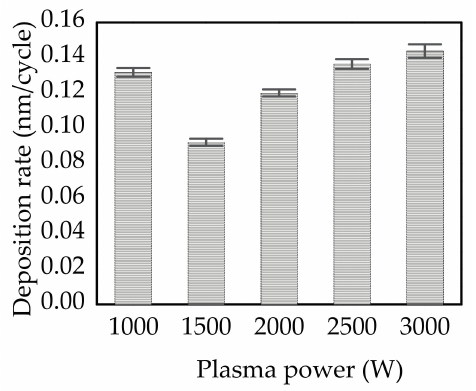
Figure 4. Deposition rate ( R D ) of PEALD SnO 2 thin films deposited at different plasma power from 1000 to 3000